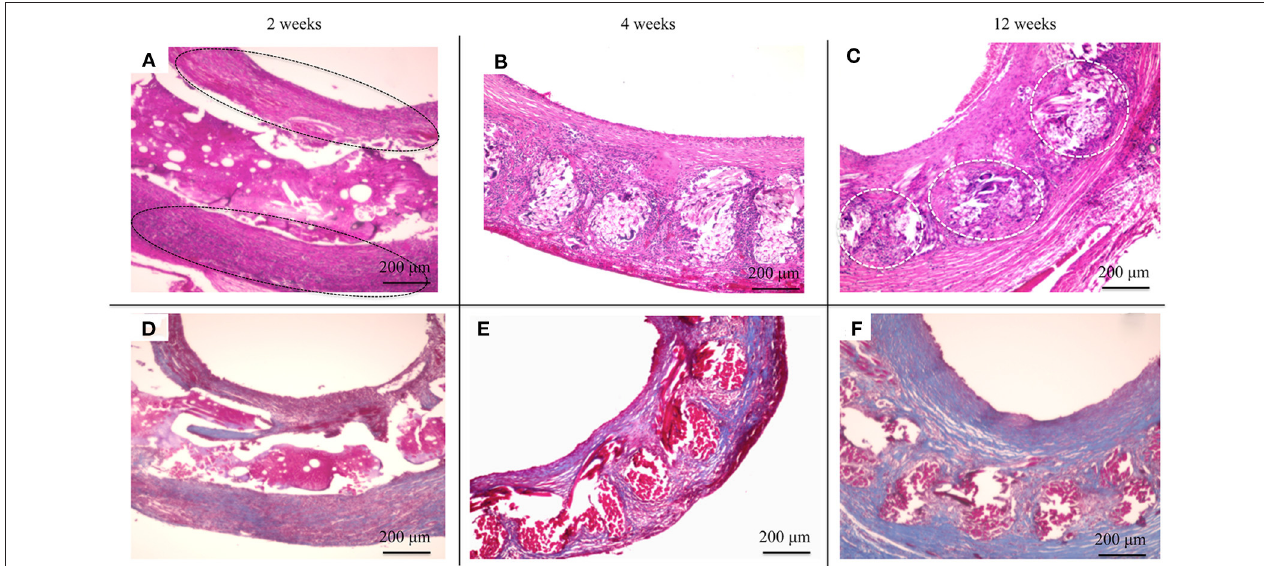
FIGURE 8 | Histological cross-section images at 2 weeks after implantation: (A) hematoxylin and eosin staining (HE) and (D) Masson’s trichrome (MTC) staining. Histological cross-section images at 4 weeks after implantation: (B) HE staining and (E) MTC staining. Histological cross-section images at 12 weeks after implantation: (C) HE staining and (F) MTC staining. The black circles indicate the inflammatory cells gathered in layers (A) , and the white circles indicate fibroblasts and macrophages had invaded the interstices of the SF fibers (C) .